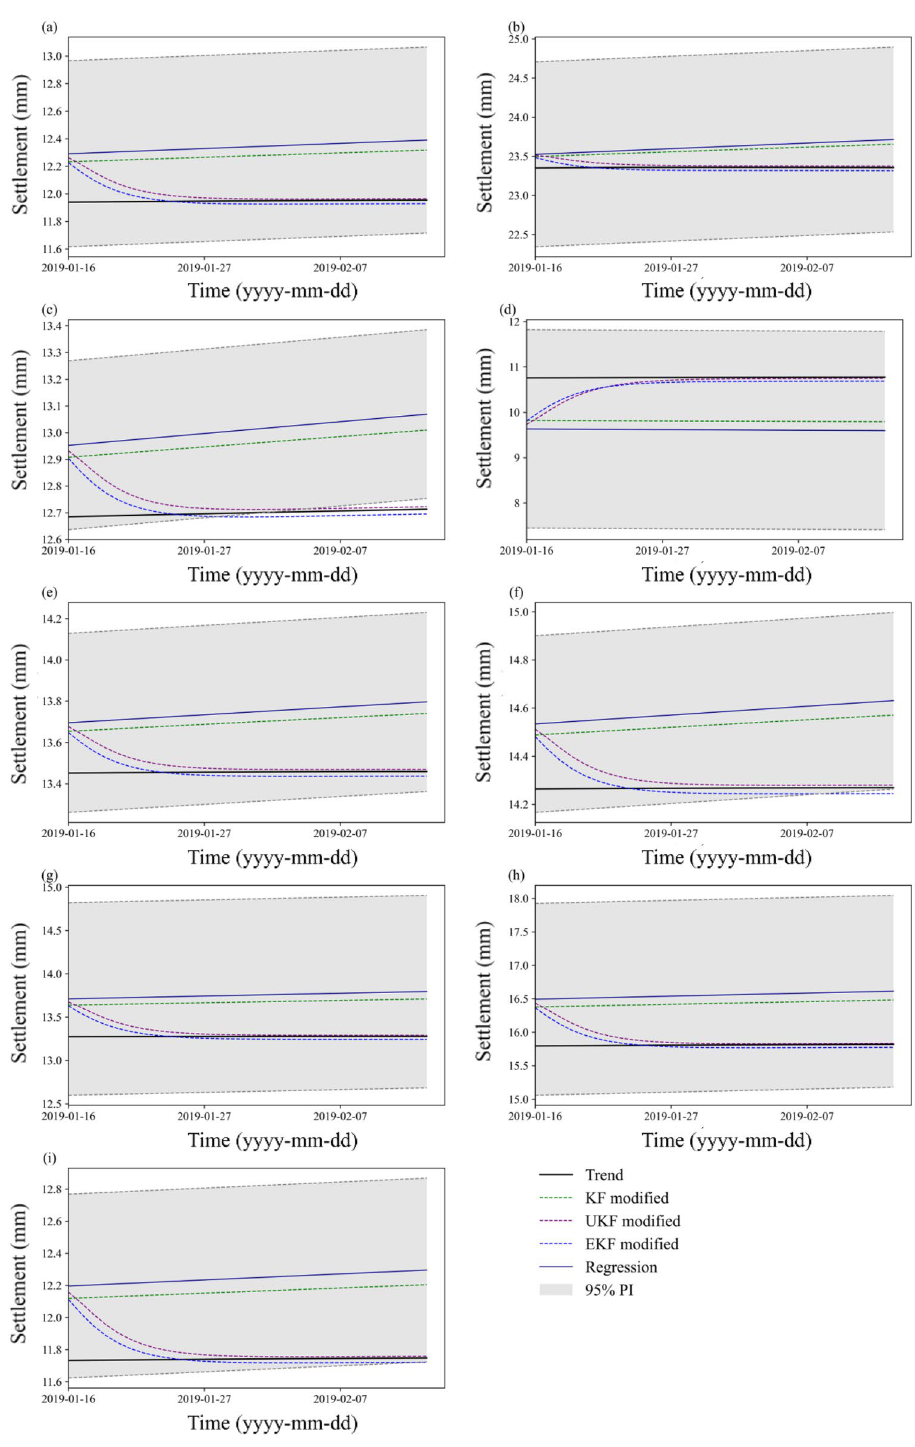
Figure 10. Prediction effect of PIs and modified outputs by KF, EKF, and UKF: ( a ) TP1-1; ( b ) TP1-2; ( c ) TP1-3; ( d ) TP2-1; ( e ) TP2-2; ( f ) TP2-3. ( g ) TP3-1; ( h ) TP3-2; and ( i )